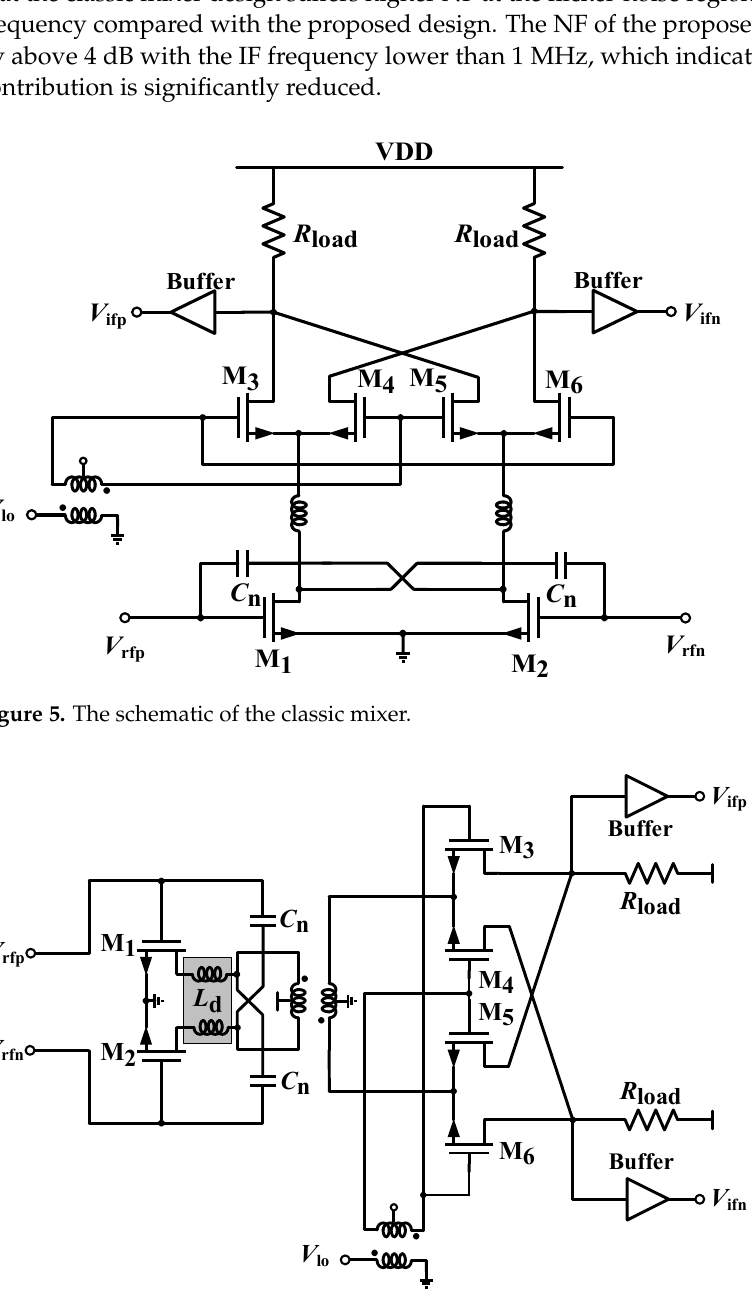
Figure 6. The schematic of the proposed double-balanced mixer.